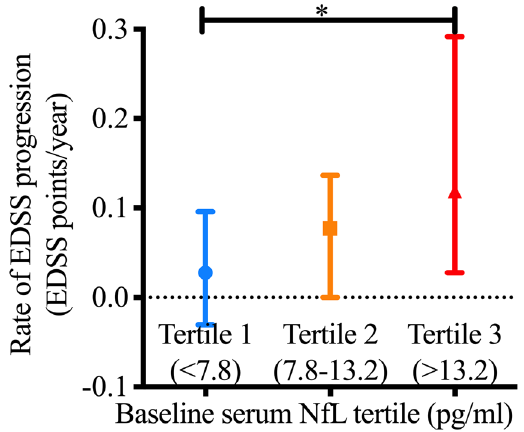
Figure 4. Baseline NfL tertile and rate of EDSS progression. Average rate of EDSS progression (median and Interquartile range) over time in subgroups of MS patients based on serum NfL tertiles at baseline (Kruskal– Wallis p = 0.020, df 2).